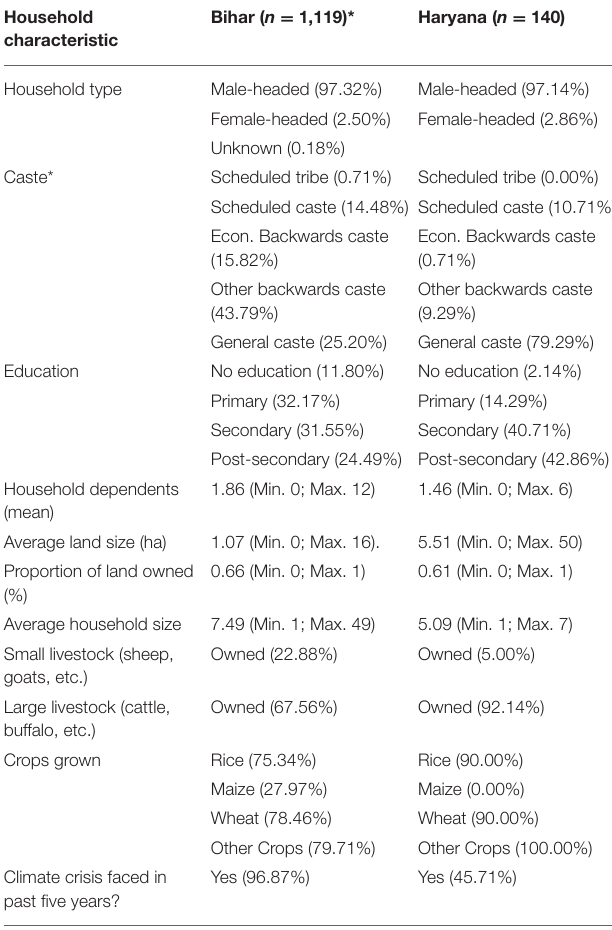
TABLE 1 | Sample population surveyed in Bihar and